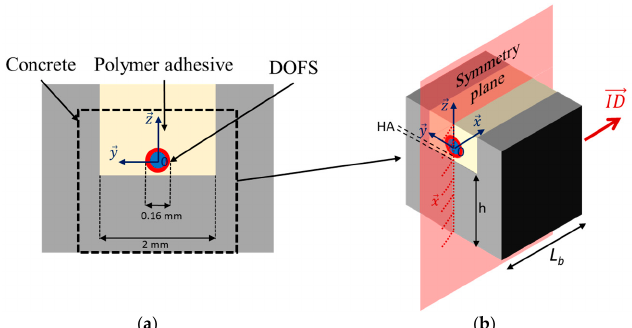
Figure 1. Simplified model used in the numerical simulation of the strain transfer process: ( a ) cross- sectional view of the system; ( b ) 3D model with boundary conditions.